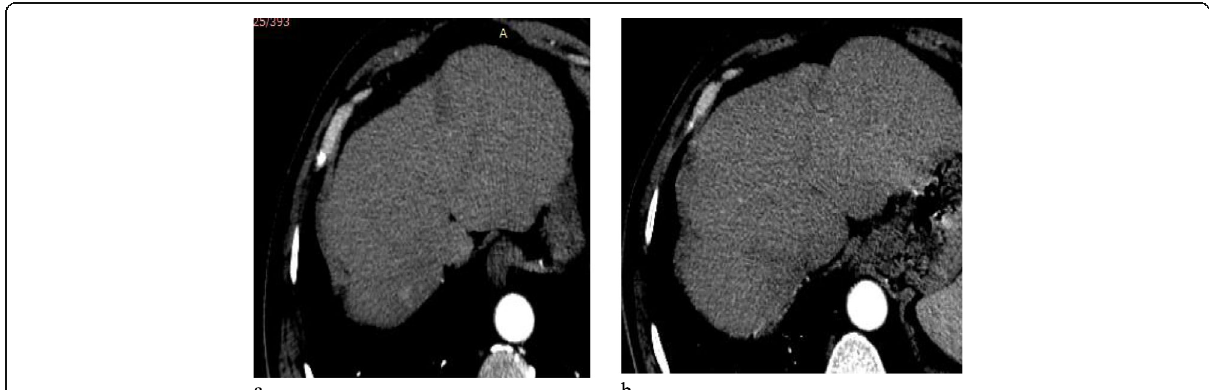
Fig. 4 Case 1: a 58-year-old male patient with cirrhosis. a MDCT in the arterial phase dated February 2017 reveals a small right hepatic lobe segment VII hyper-enhancing nodule measuring 11 mm showing no washout in the venous nor the delayed phases (not shown); this lesion is